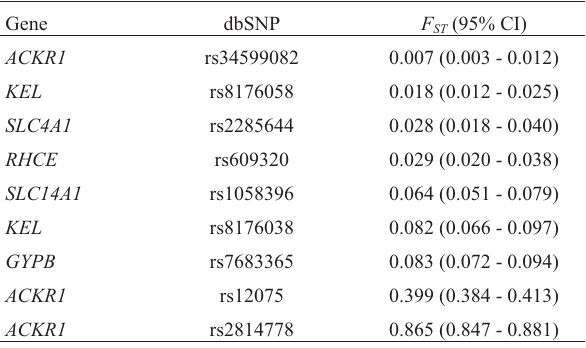
Figure 1 - Genetic distance among the populations analyzed in this study based on blood group alleles. Table 4 - SNPs population